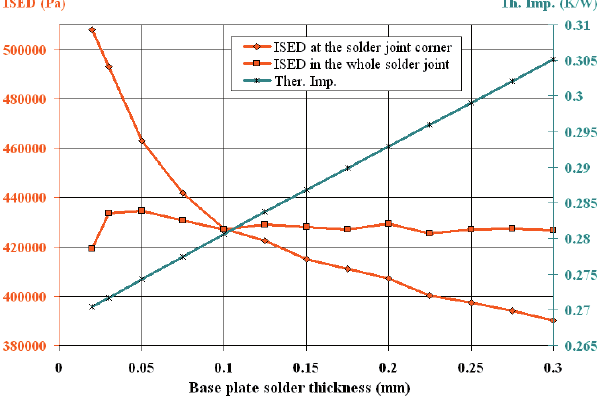
Fig. 24. Evolution of base plate solder ISED and module thermal impedance with base plate solder thickness.